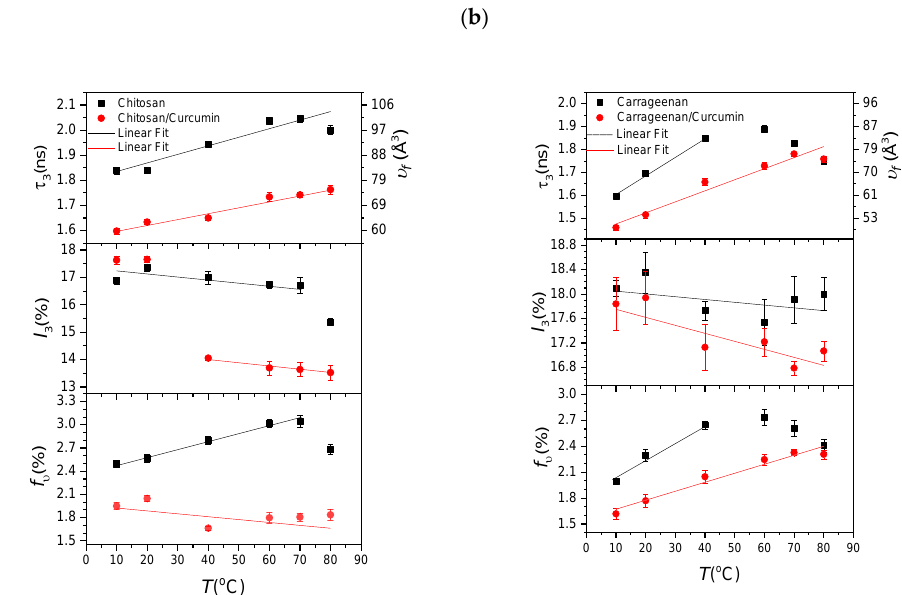
Figure 3. The o-Ps lifetime (with the corresponding free volume hole size on the left axis), intensity, and free volume fraction versus temperature: ( a ) chitosan and chitosan/curcumin sheets, and ( b ) carrageenan and carrageenan/curcumin. Data visibly out of linearity were excluded from the fit.